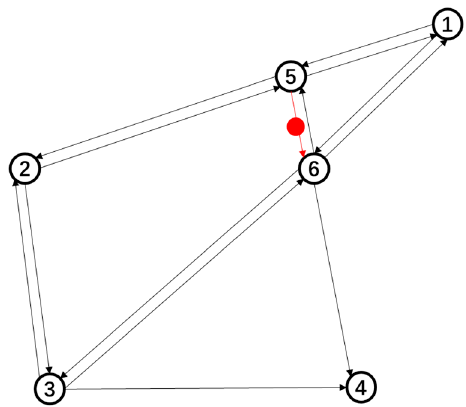
Figure 2. Experimental road network.